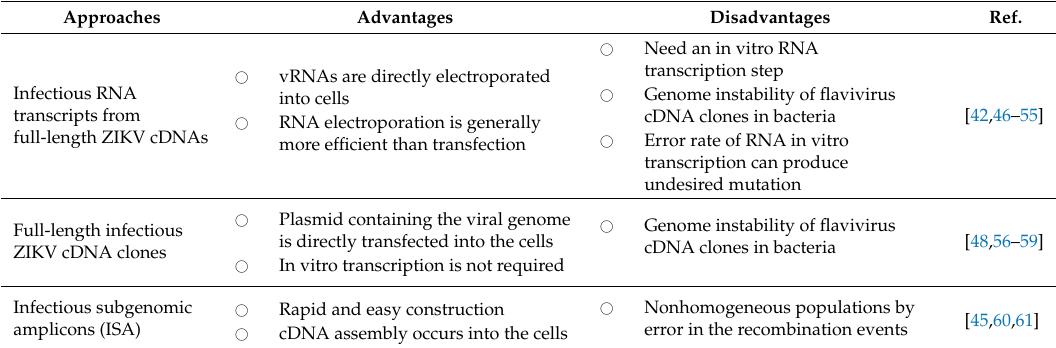
Table 1. ZIKV reverse genetics techniques.